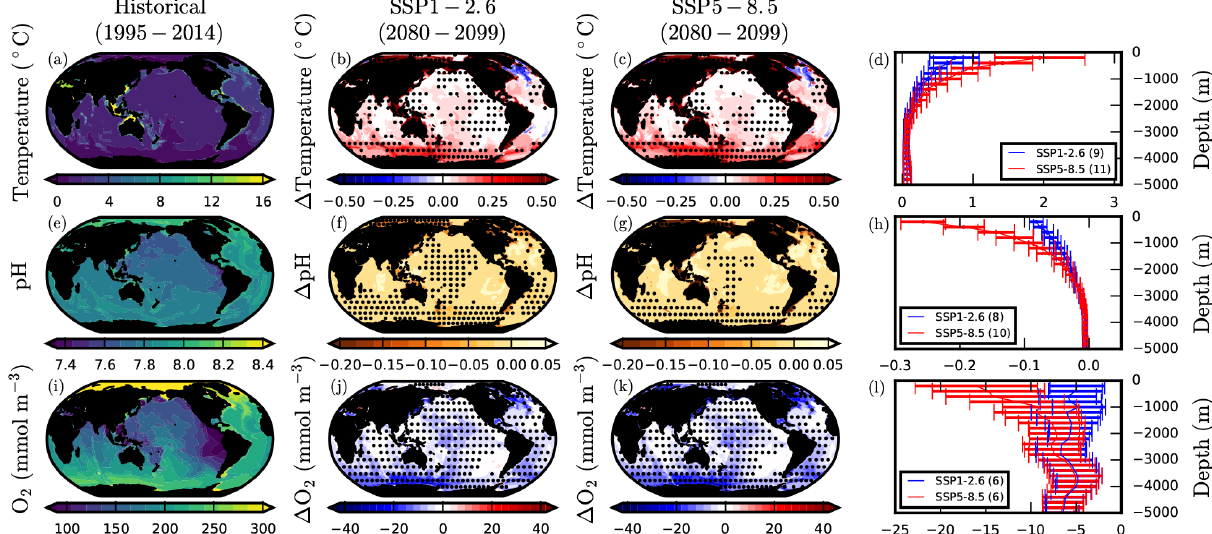
Figure 8. Projections of multiple benthic ocean impact drivers under SSP1-2.6 and SSP5-8.5. CMIP6 mean historical climatologies and anomalies in benthic (a–d) temperature ( ◦ C), (e–h) pH, and (j–l) dissolved O 2 concentration (mmolm − 3 ). Anomalies are 2080–2099 mean values relative to 1995–2014. Stippling designates areas of projection robustness. For temperature and pH this is defined as the magnitude of the mean anomaly exceeding the inter-model SD. For O 2 this is defined as at least 80% model sign agreement. Vertical profiles show global mean benthic anomalies in 200m depth intervals, with error bars denoting the inter-model